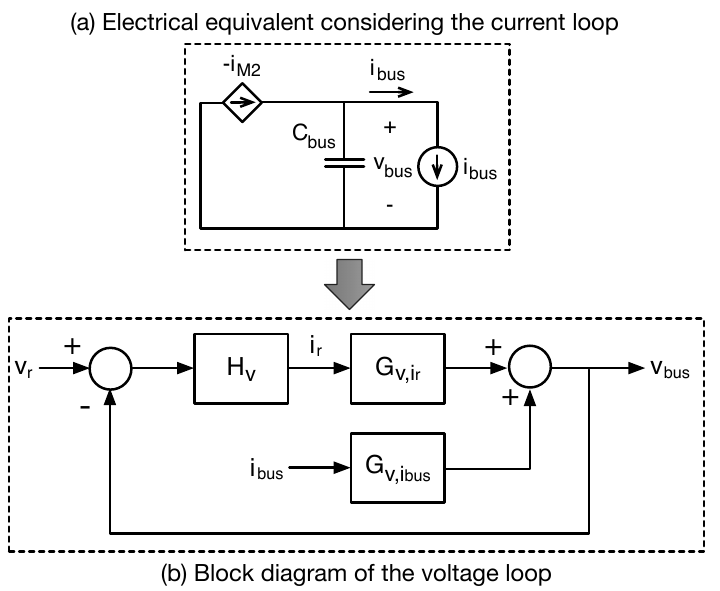
Figure 3. Voltage loop based on a cascade